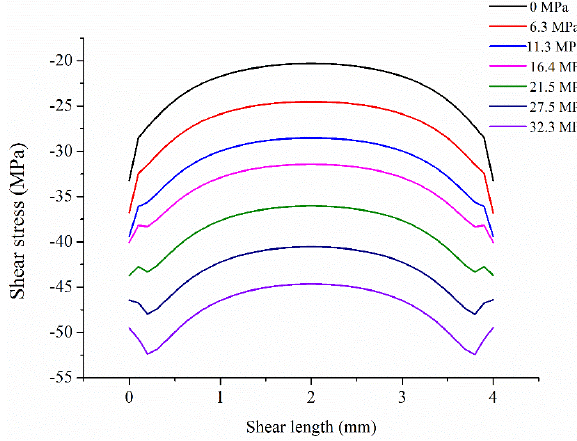
Figure 12: Finite element model